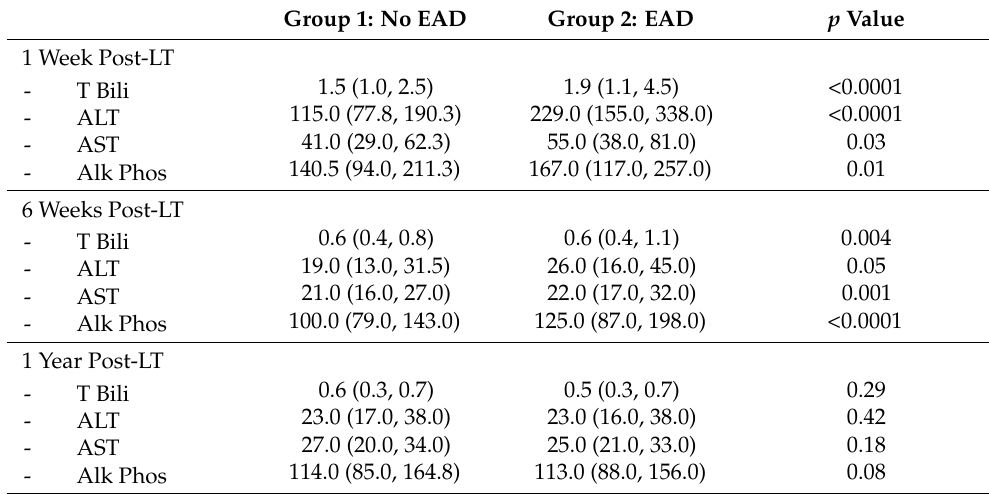
Table 3. Post-transplant laboratory values.